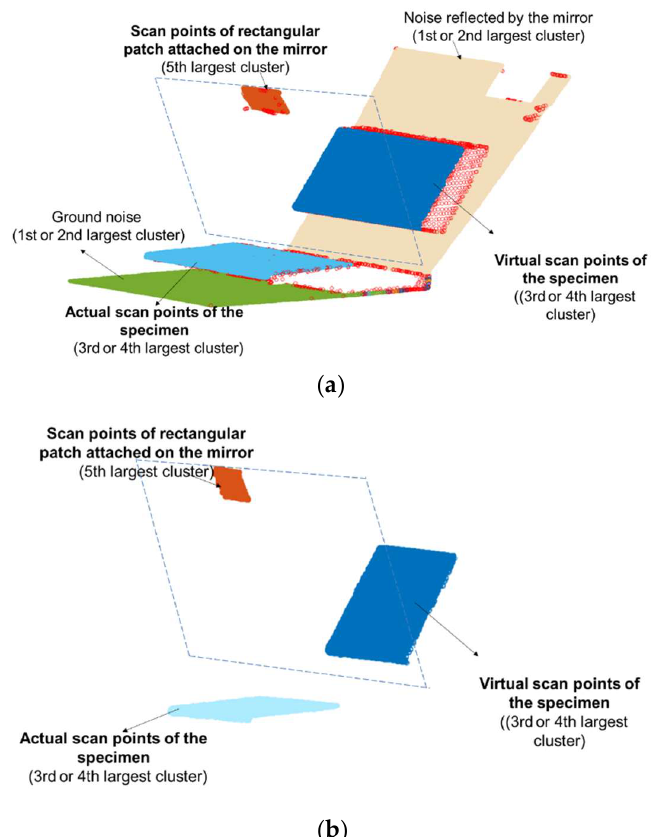
Figure 7. Data preprocessing results: ( a ) implementation result of the density-based spatial clustering of applications with noise (DBSCAN) on the raw scan points; and ( b ) extraction and separation of scan points corresponding to the specimen and the rectangular patch attached to the mirror.